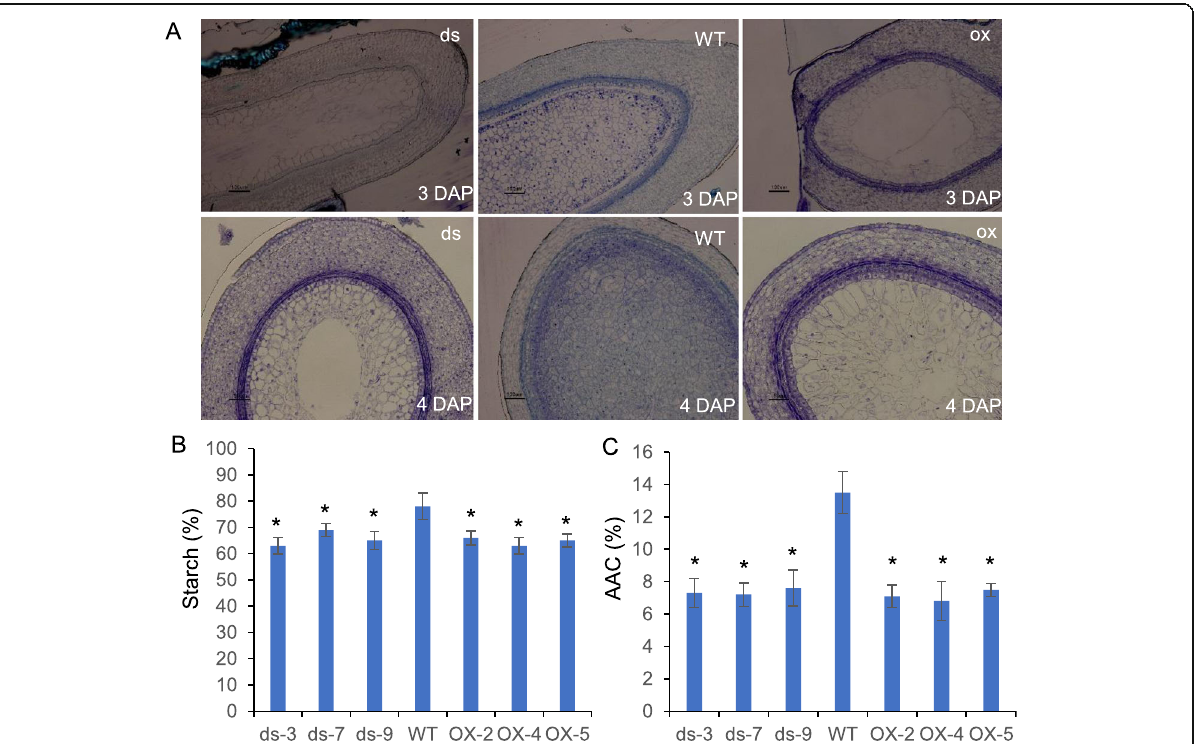
Fig. 2 Endosperm starch granules and starch content of SDG711 transgenic plants. a. Cross sections of seeds at 3 DAP and 4 DAP. ds indicates independent lines of SDG711 RNAi transgenic plants; OX indicates independent lines of SDG711 overexpression transgenic plants. b. Total starch content in endosperm of SDG711 transgenic plants. c. AAC in endosperm of SDG711 transgenic plants. *significantly different (p < 0.01). Values are mean ± SD. ds3, ds-7 and ds-9 indicate independent lines of SDG711 RNAi transgenic plants; OX-2, OX-4 and OX-5 indicate independent lines of SDG711 overexpression transgenic